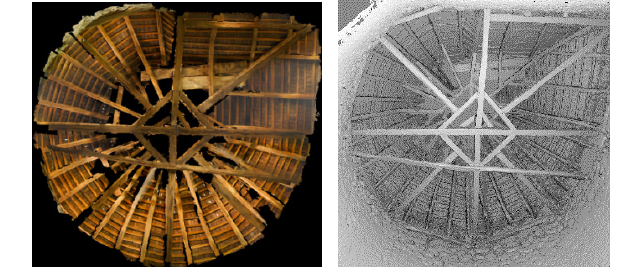
Figure 13. Orthophoto (left) and 3D model of the timber truss (right)